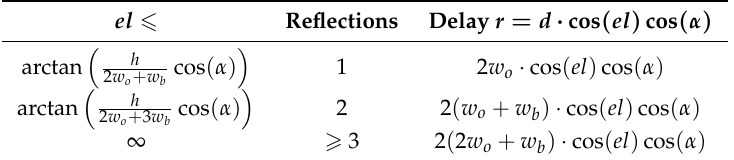
Table 3. Table of NLOS pseudorange delay measurements due to